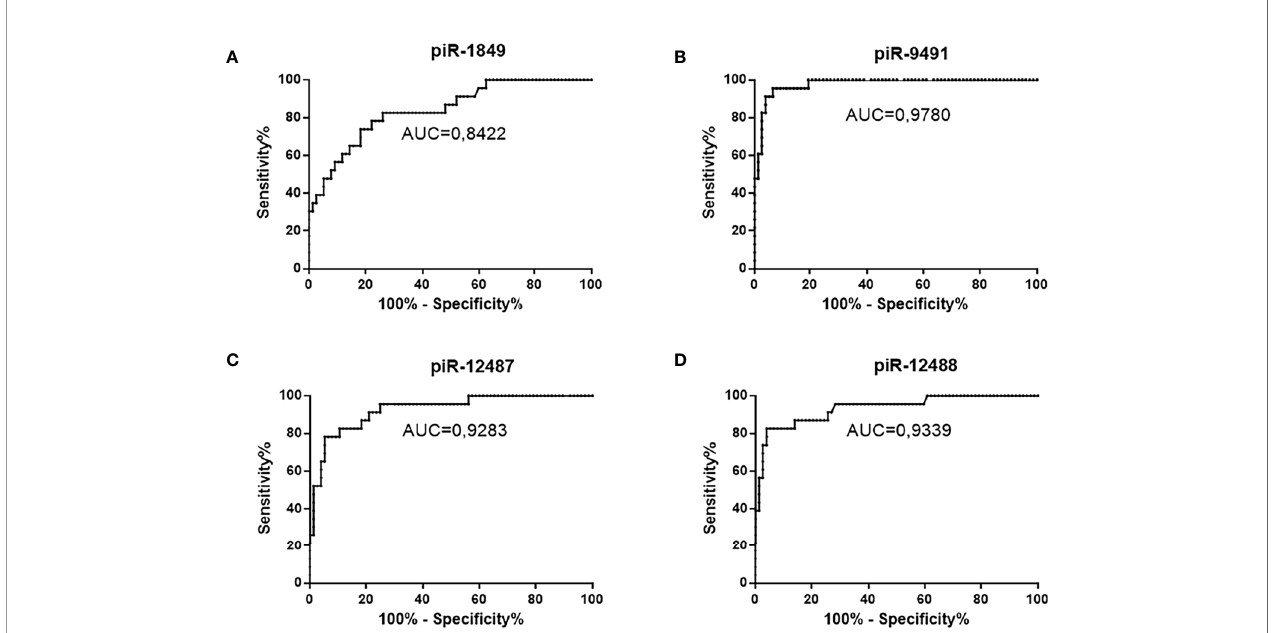
FIGURE 4 | ROC analysis of all successfully validated piRNA molecules and their distinguishing ability between tumors and non-tumor controls. (A) piR-1849, AUC 0.8422, sensitivity 82.6%, speci fi city 74%; (B) piR-9491 AUC 0.978, sensitivity 100%, speci fi city 80.5%; (C) piR-12487 AUC 0.9283, sensitivity 91.3%, speci fi city